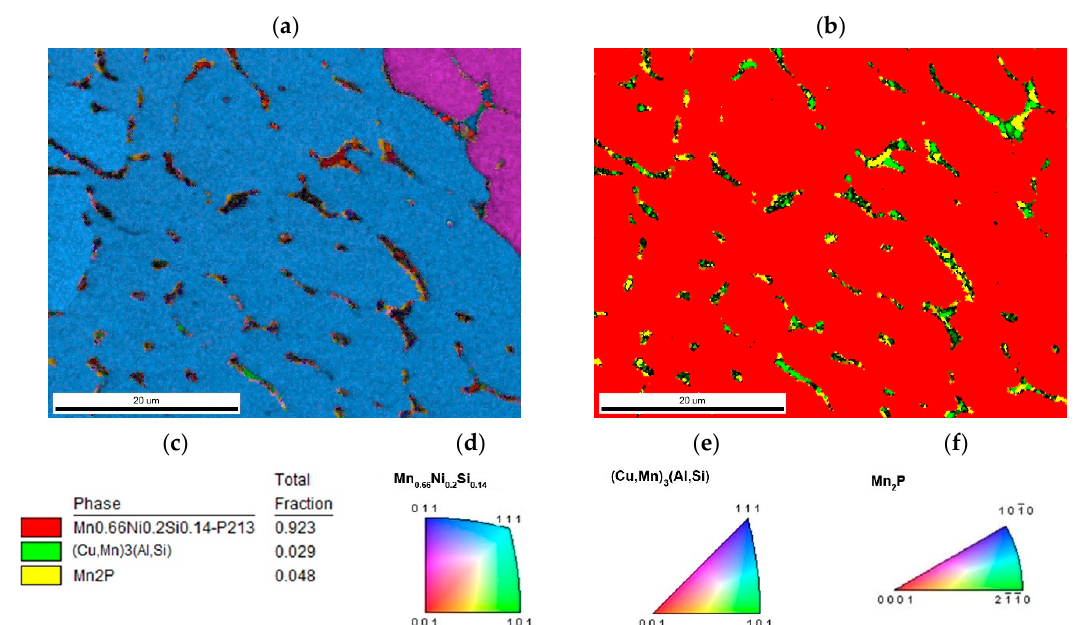
Figure 3. The sample with stoichiometric amount of aluminum ( a ) inverse pole figure (IPF) map overlayed on a greyscale Image Quality map; ( b ) phase distribution overlayed on a greyscale Confidence Index map, whose color code and percentage of area coverage are given in ( c ). Colorized legend of particular phases are in ( d – f ).